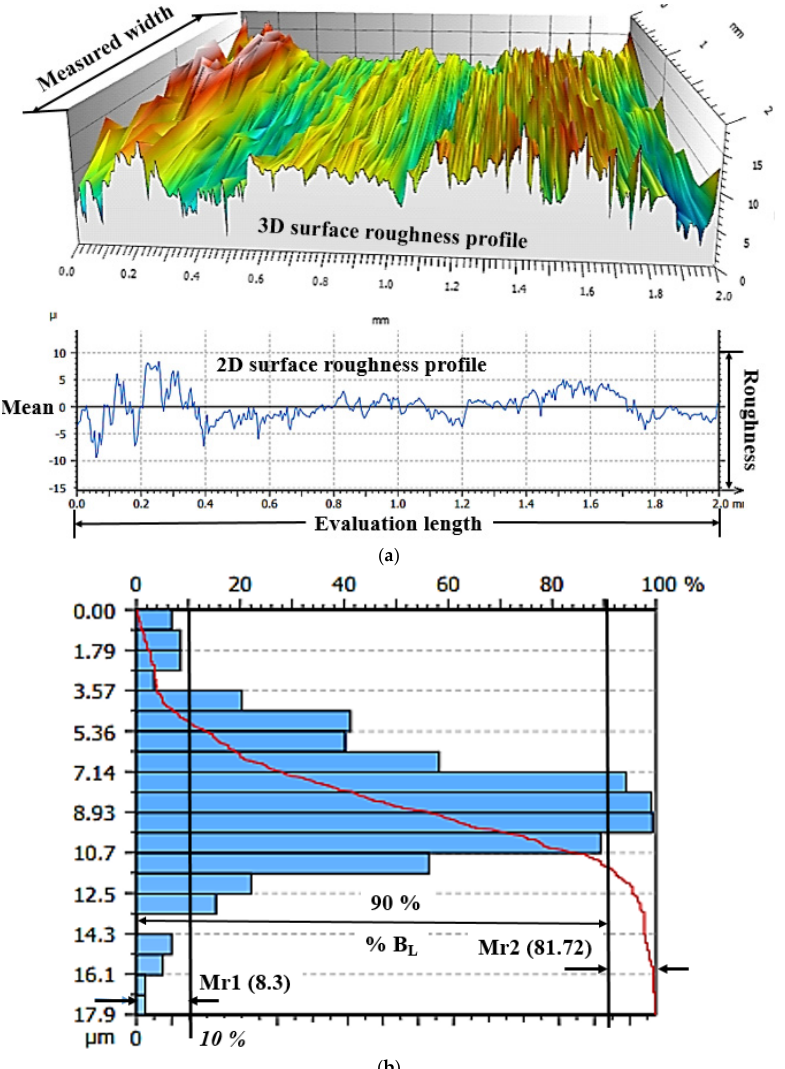
Figure 9. The 3D surface roughness measurements of miniature-sized ratchet wheel manufactured by WEDM using optimal machining parameters: ( a ) 3D and 2D surface roughness profiles; ( b ) Abbott–Firestone curve.